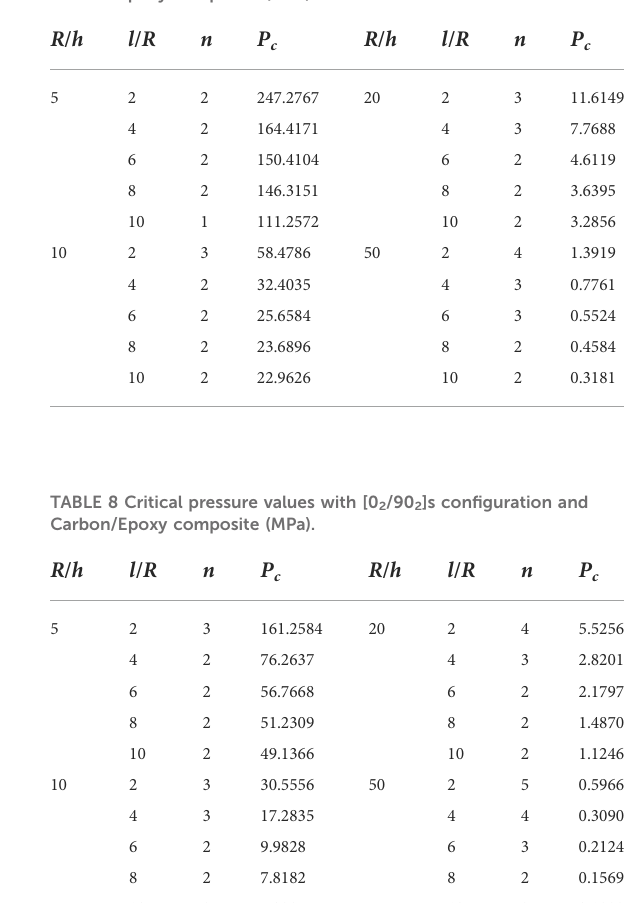
TABLE 4 Critical pressure values with [0/90/0]s con fi guration and Carbon/Epoxy composite (MPa).